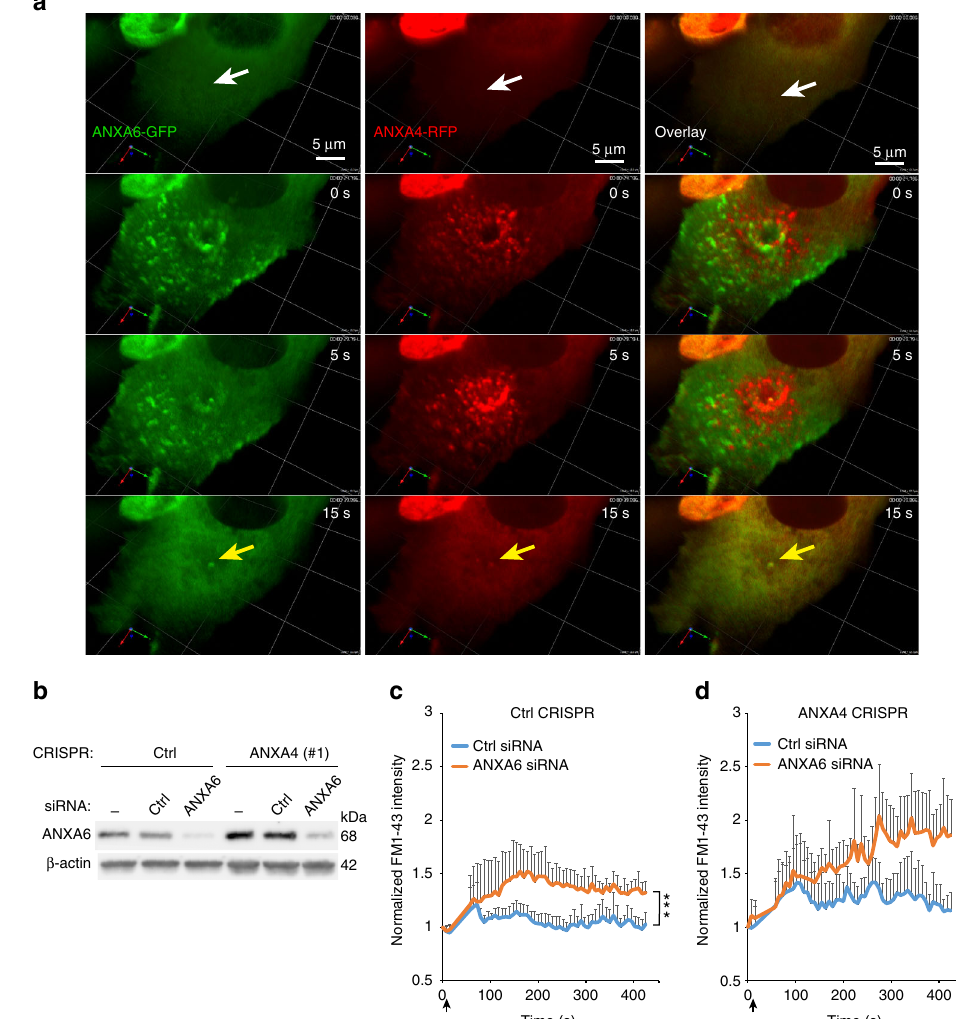
Fig. 6 ANXA6 is recruited to wound edges and required for repair. a Representative sequential 3D images of MCF cell showing the localization of ANXA6- GFP and ANXA4-RFP in response to laser injury (white arrows indicate injury site). Cells were injured by shooting through the cell to obtain a hole with clear edge. A putative repair cap de fi ning where the edges have fused is visible in the middle (yellow arrow). b Immunoblot showing ANXA6 protein levels in CRISP Ctrl and MCF7A4-CRISPR (#1) cells or in similar cells treated with ANXA6 or Ctrl siRNA for 48 h. c Cell membrane repair kinetics in ANXA6 siRNA-treated cells compared to Ctrl siRNA-treated cells upon laser injury measured by membrane impermeable FM1-43 dye in fl ux in MCF7Ctrl CRISPR or d MCF7A4 -- CRISPR (#1). Error bars represent S.D. for at least seven independent cells per condition. P values based on t -test: * P ≤ 0.05, ** P ≤ 0.01. ** P ≤